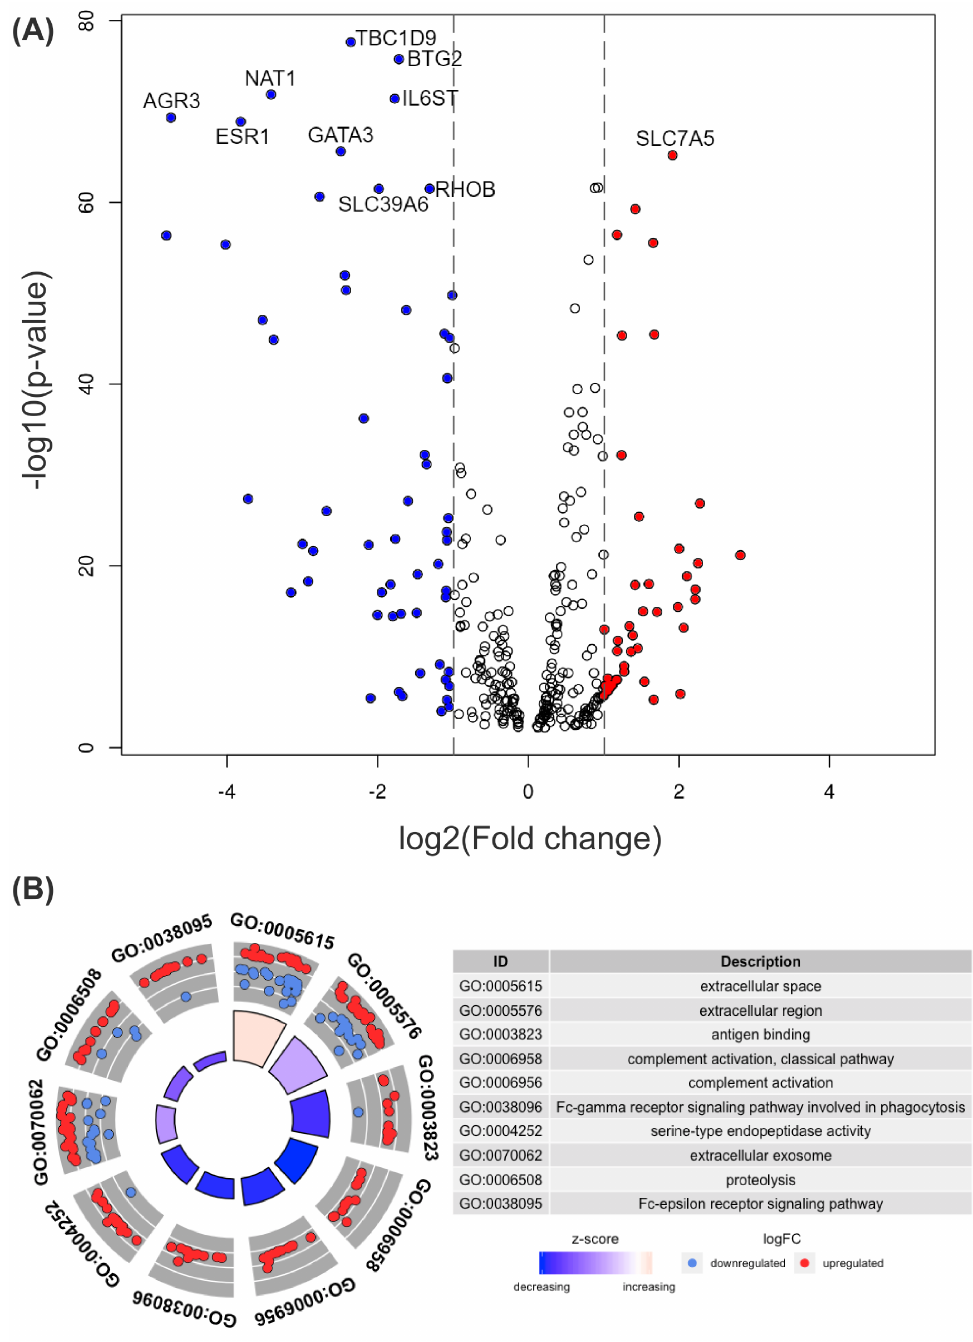
Figure 2. ( A ) Volcano plot for comparing differentially expressed genes in two groups, wtTP53 and mTP3. The horizontal axis represents the fold change (FC) between the two groups on a log2 scale, and the vertical axis shows the negative logarithm to the base 10 of p values from the t -test. A gene with a higher expression level in mTP53 than in wtTP53 has a positive FC and is shown as a red dot. A gene with a lower expression level in mTP53 than in wtTP53 has a negative FC and is shown as a blue dot. Top 10 genes with low adjusted p -values by Benjamini–Hochberg procedure are labeled with their names. ( B ) GO circle plot and GO terms for genes with significant FC. Genes with higher expression levels in mTP53 than in wtTP53 are shown as red dots, and genes with lower expression levels in mTP53 are shown as blue dots. The z-score is the number of overexpressed genes minus the number of underexpressed genes divided by the square root of the